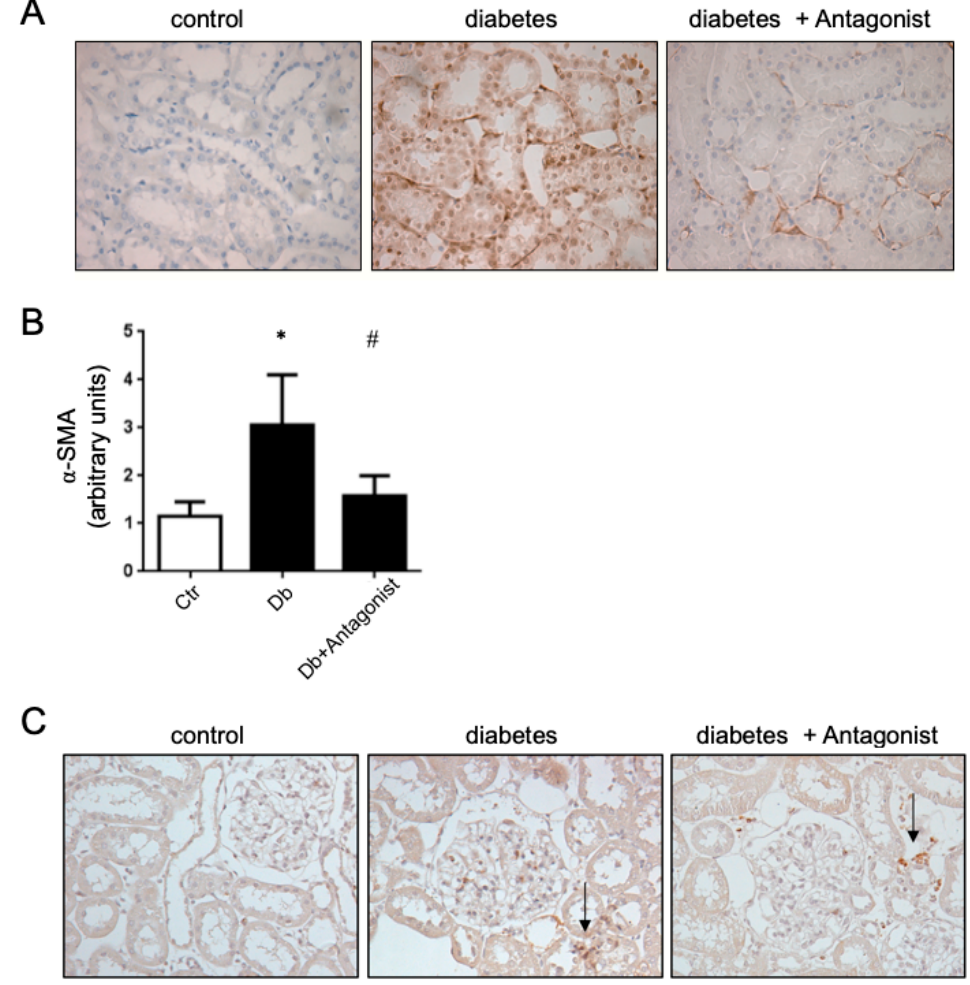
Figure 6. The antagonist of ADORA3 attenuates profibrotic activation of cells in diabetic rats. ( A ) The images are representatives of immunohistochemical detection of α -SMA in kidney sections from experimental groups. Original magnification 400 × . ( B ) The graph shows the quantitative analysis of α -SMA staining on 10 microscopic fields per slice from animals belonging to each experimental group using the UN-SCANIT 2.0 software. n = 5 in each group. *, p < 0.05 vs. control group; # , p < 0.05 vs. Diabetic group. ( C ) The images are representatives of tubulointerstitial infiltrating monocyte/macrophages CD68+ in the kidney cortex of experimental groups. Arrows indicates infiltrating CD68+ cells. Original magnification 400×.